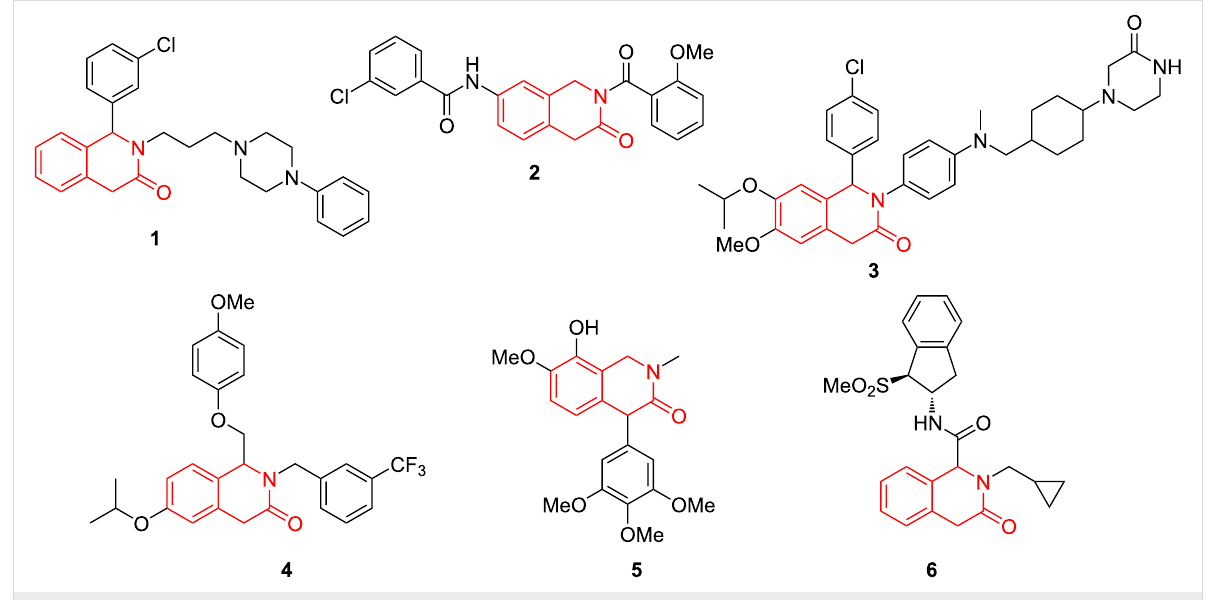
Figure 1: Diverse bioactive compounds based on the privileged 1,4-DHIQ scaffold.